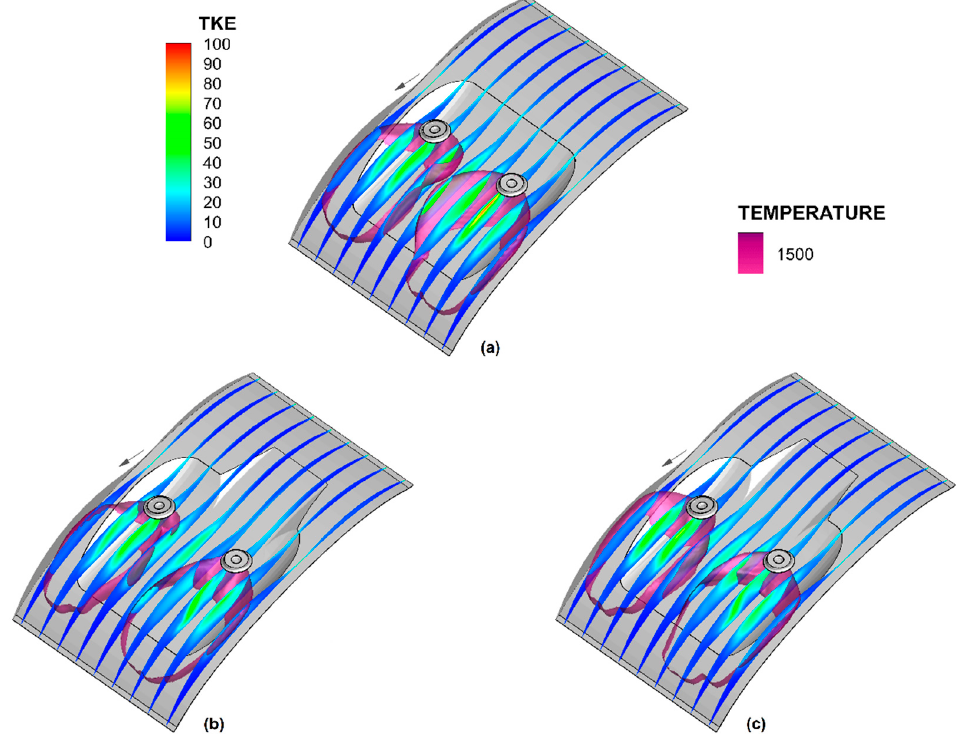
Figure 8. Distribution of TKE (m 2 /s 2 ) and representation of temperature iso-surface of 1500 K at 20°EA after TDC (40°EA after ST) for ( a ) N-slot, ( b ) L-slot, and ( c ) C-slot cases.